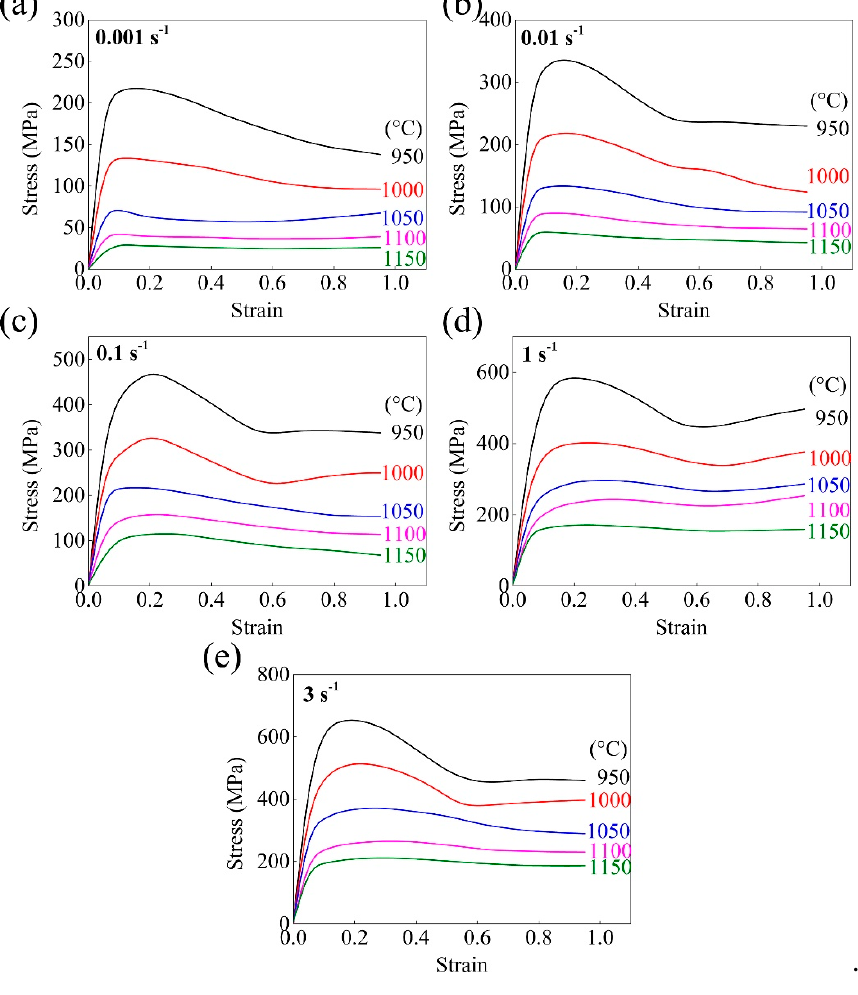
Figure 2. Stress strain curves of GH4698 compressed at the strain rates of ( a ) 0.001 s − 1 , ( b ) 0.01 s − 1 , ( c ) 0.1 s − 1 , ( d ) 1 s − 1 , and ( e ) 3 s − 1.